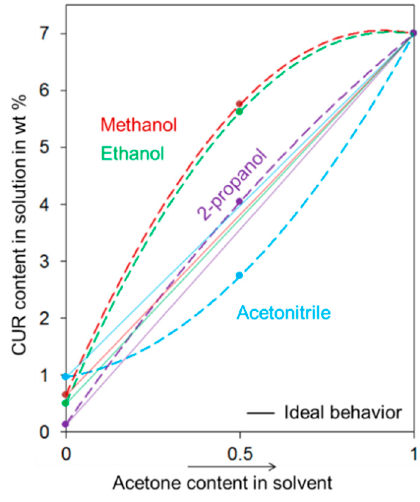
Figure 5. Effect of anti-solvents methanol, ethanol, 2-propanol and acetonitrile on the solubility of CUR in acetone at 30 °C. Symbols represent experimental data, curves are just guide to the eyes. Dashed curves originate from experimentally determined solubility values in the respective 50 / 50 (wt / wt) acetone / anti-solvent mixtures. Thin solid lines represent ideal linear solubility behaviors.